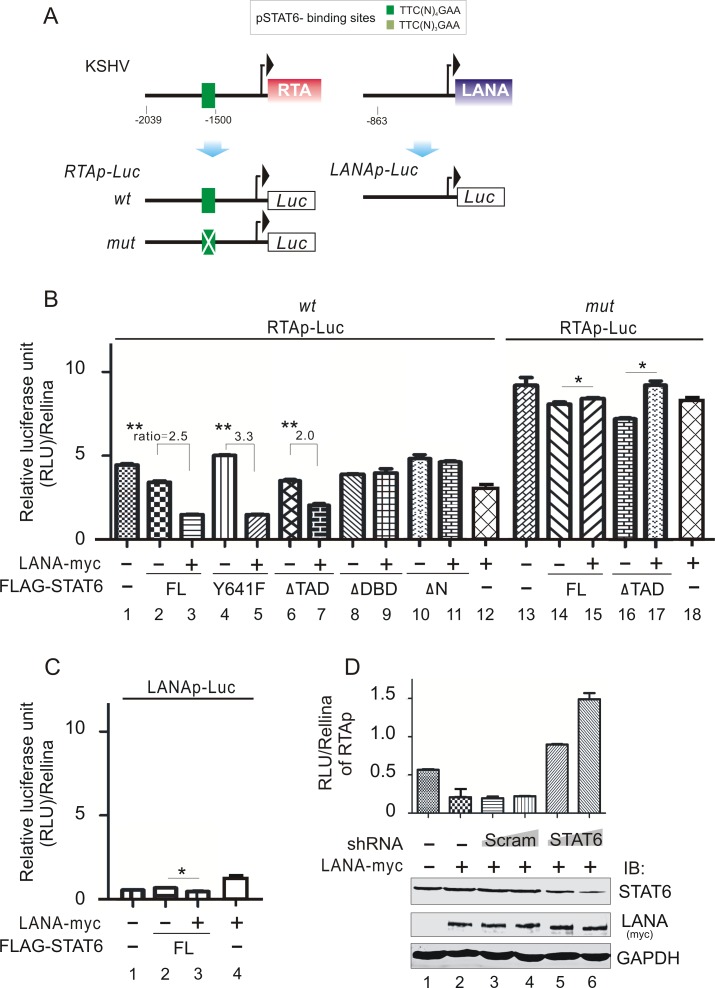
LANA enhances the inhibitory function of STAT6 on transcription of RTA through STAT6-binding sites within RTA promoter.(A) Schematic of putative STAT6-binding sites within RTA and LANA promoters. The RTA (or LANA) promoter-driven luciferase reporters RTAp-Luc (or LANAp-Luc) are shown at the bottom panel. LANA enhances the inhibitory function of STAT6 on transcription of RTA promoter (B) but not LANA promoter (C). HEK293 cells co-transfected with the indicated promoter-reporters combination with full-length (FL) STAT6 or its mutants in the presence or absence of LANA were subjected to reporter assay. Relative luciferase unit (RLU) normalization with Rellina activity was analyzed. Data is presented as meansαSD of three independent experiments. Asterisks indicate P value as follows: *, P>0.05, and **, P<0.05. (D) Knockdown of STAT6 abolishes the inhibitory function of LANA on RTA transcription. HeLa cells co-transfected with the indicated plasmids in the presence of RTAp-luc reporter, were subjected to reporter assays as described in panel B.